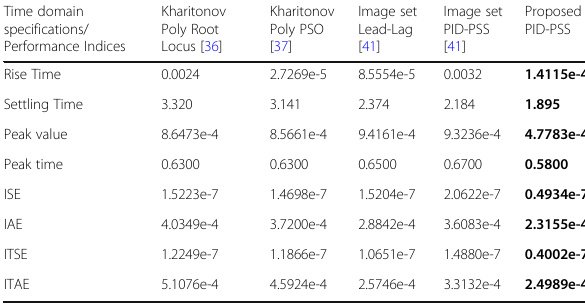
Table 8 Comparision of performance measures between the proposed and existing methods at P = 1.2 p.u. and Q = 0.2p.u . P = 1.2 p . uandQ = 0.2 p .